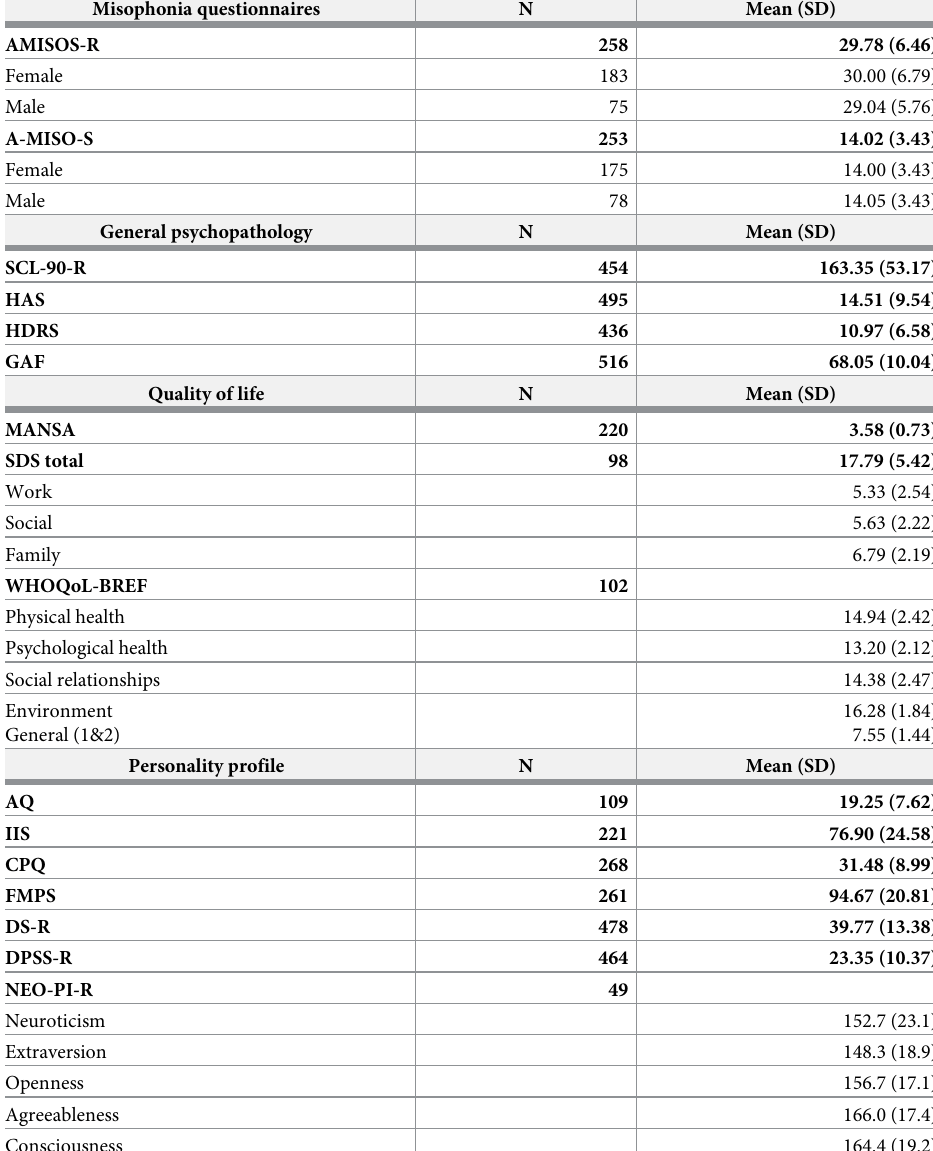
Table 4. Characteristics of misophonia